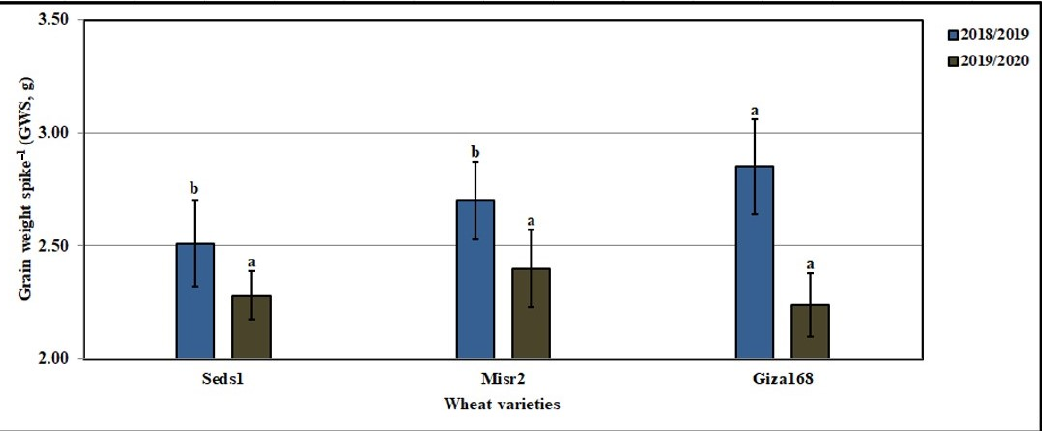
Figure 11. Influence of wheat varieties on grain weight spike − 1 (GWS, g) in clay loam soil in 2018/2019 and 2019/2020 seasons. Bars in the same years with a different letter indicate significant differences between treatments at p ≤ 0.01. HS 1, HS 2 , HS 3 represent HS applied as foliar spray at 1.0, 2.0, 4.0 g L − 1 , respectively, HS 4 , HS 5 , HS 6 represent HS applied as soil application at 5.04, 7.56, 10.08 kg ha − 1 .